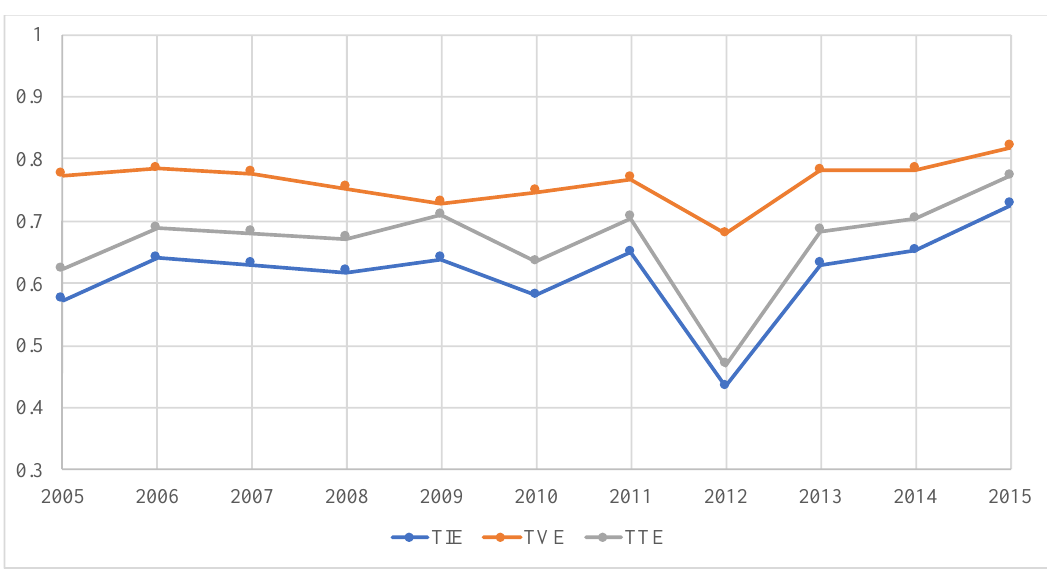
Figure 3. The variation of average efficiency scores over time. TIE, technological innovation efficiency; TVE, technology investment efficiency; TTE, technology transformation efficiency.